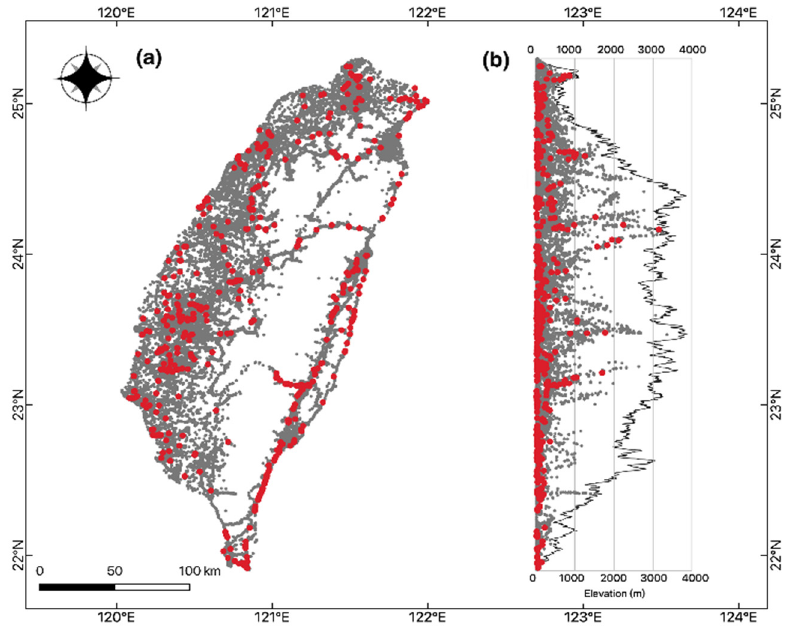
Figure 2. ( a ) Geographic and ( b ) elevational distributions of roadkill events of bats (red dot, 442 grids) and non-bat vertebrates (dark gray dot, 9927 grids) in Taiwan collected by TaiRON from 2013 to 2018. Note some dots might be overlapped and not shown .